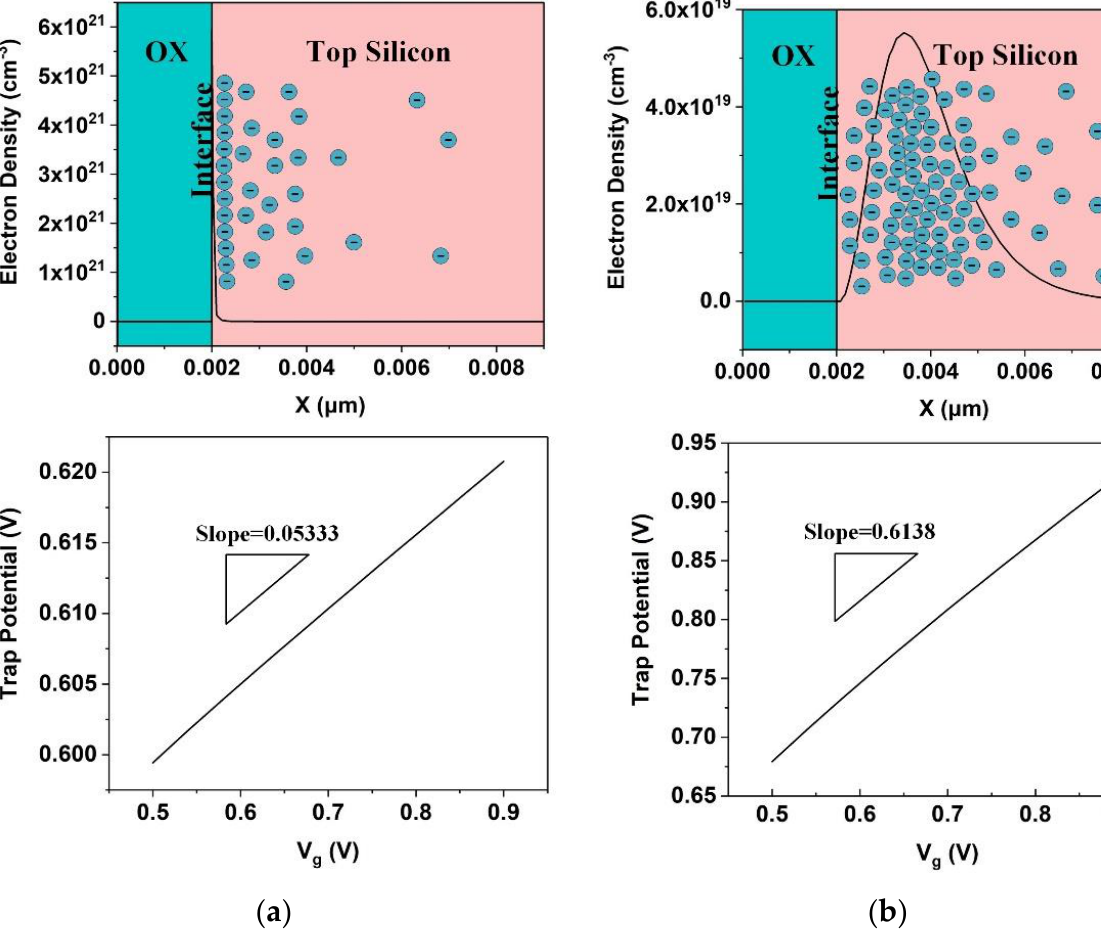
Figure 8. The results of the simulations: ( a ) at 10 K with quantum correction disabled and ( b ) at 100 K with quantum correction enabled.